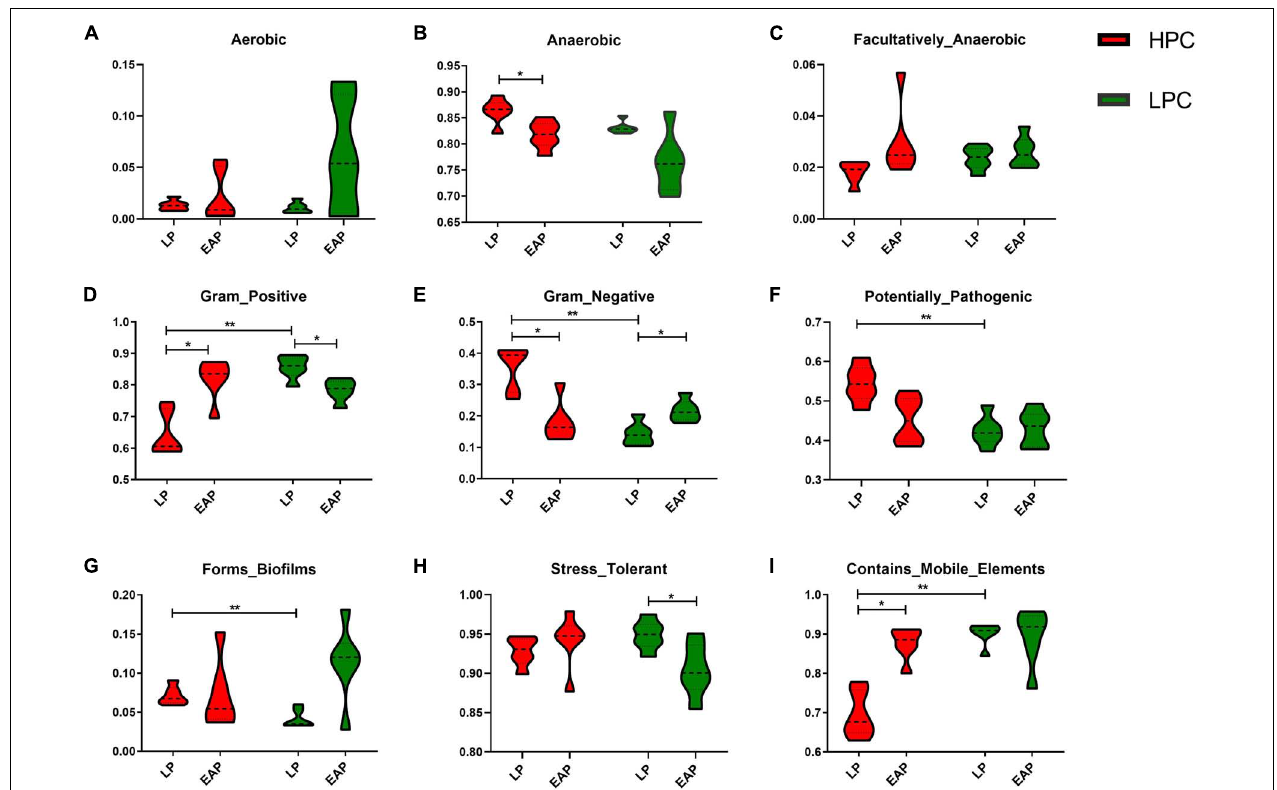
FIGURE 6 | Metabolic phenotypes of gut microbiota from high productive capacity (HPC) and low productive capacity (LPC) sows at late pregnancy (LP) and early stage after parturition (EAP) stage. (A–I) Different indices included in microbial phenotypes. Wilcoxon signed-rank test (LP vs. EAP) or Mann–Whitney U -test (HPC vs. LPC) was applied. ∗ P < 0.05, ∗∗ P < 0.01 ( n =